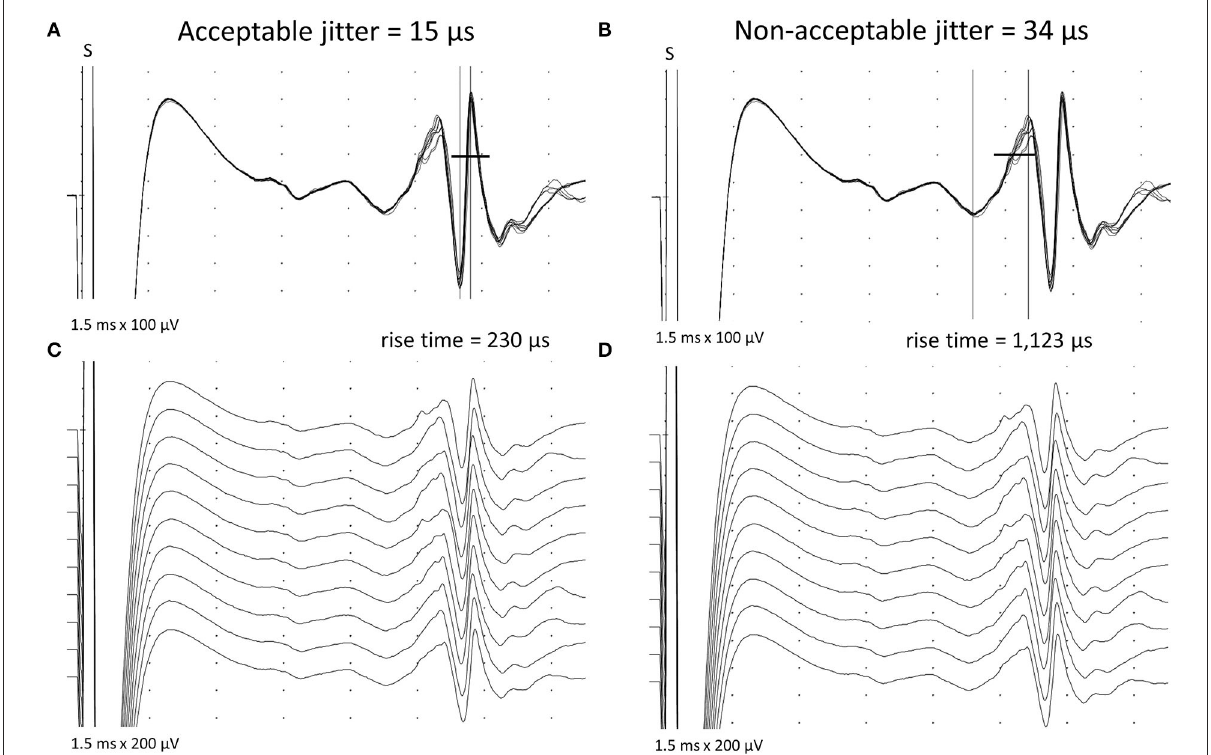
FIGURE2 Acceptable and non-acceptable apparent single-fiber action potentials are shown after stimulation jitter (S = stimulus) in the Tibialis Anterior muscle. (A) Acceptable spikes have a fast-rising phase (less than 300 µ s) without notches or shoulders, a well-defined peak, and a constant shape at consecutive discharges (C) . Note the parallel negative-going deflection on the acceptable spikes on superimposed traces (A) . In (B) and (D) , non-acceptable spikes with slow rising phase and non-parallel depolarizing negative lines, giving a false increased